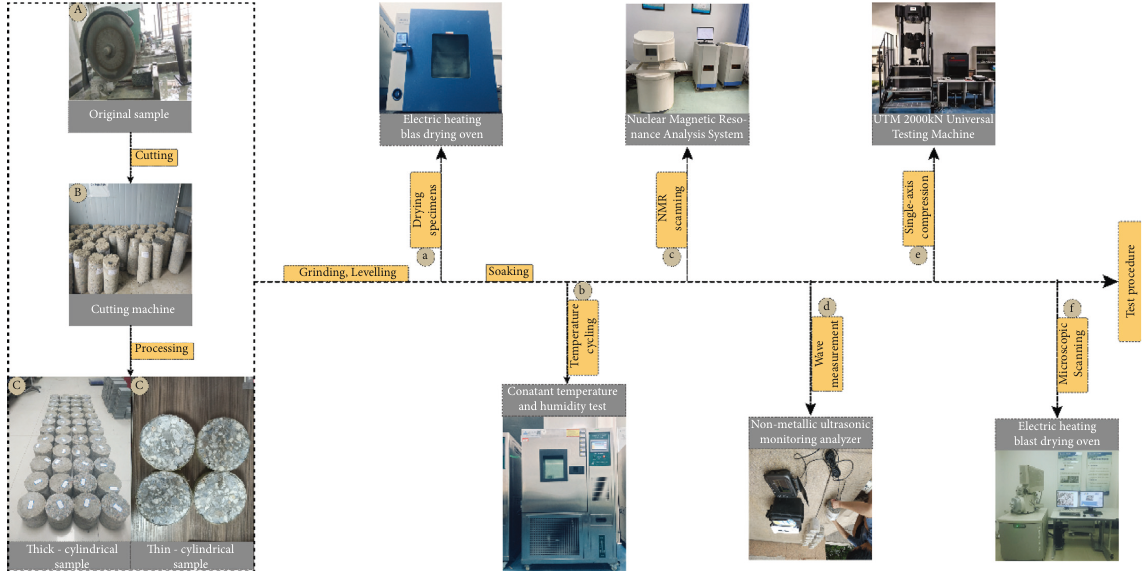
Figure 1: Specimen preparation and test procedure flow.